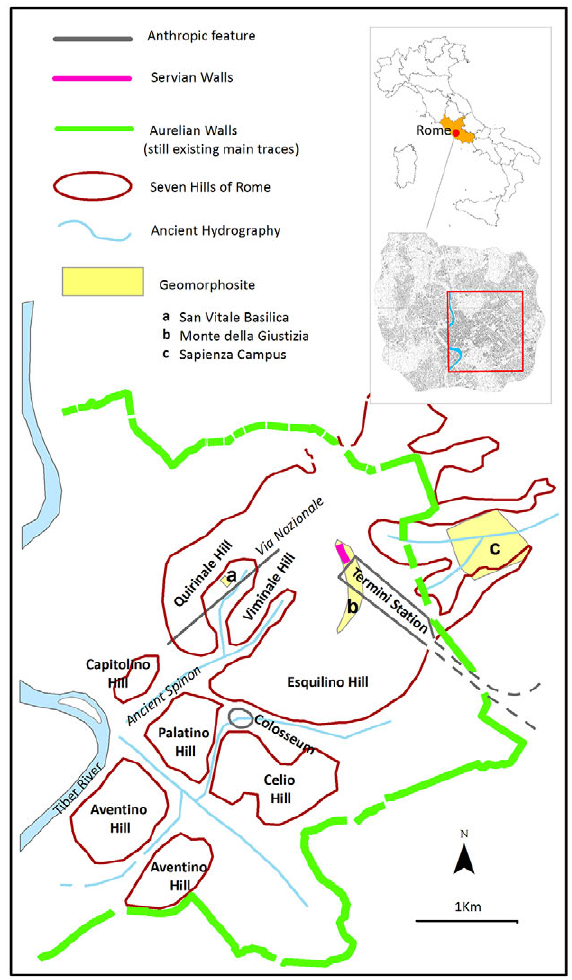
Fig. 2. Study area: location and main elements described in the text.